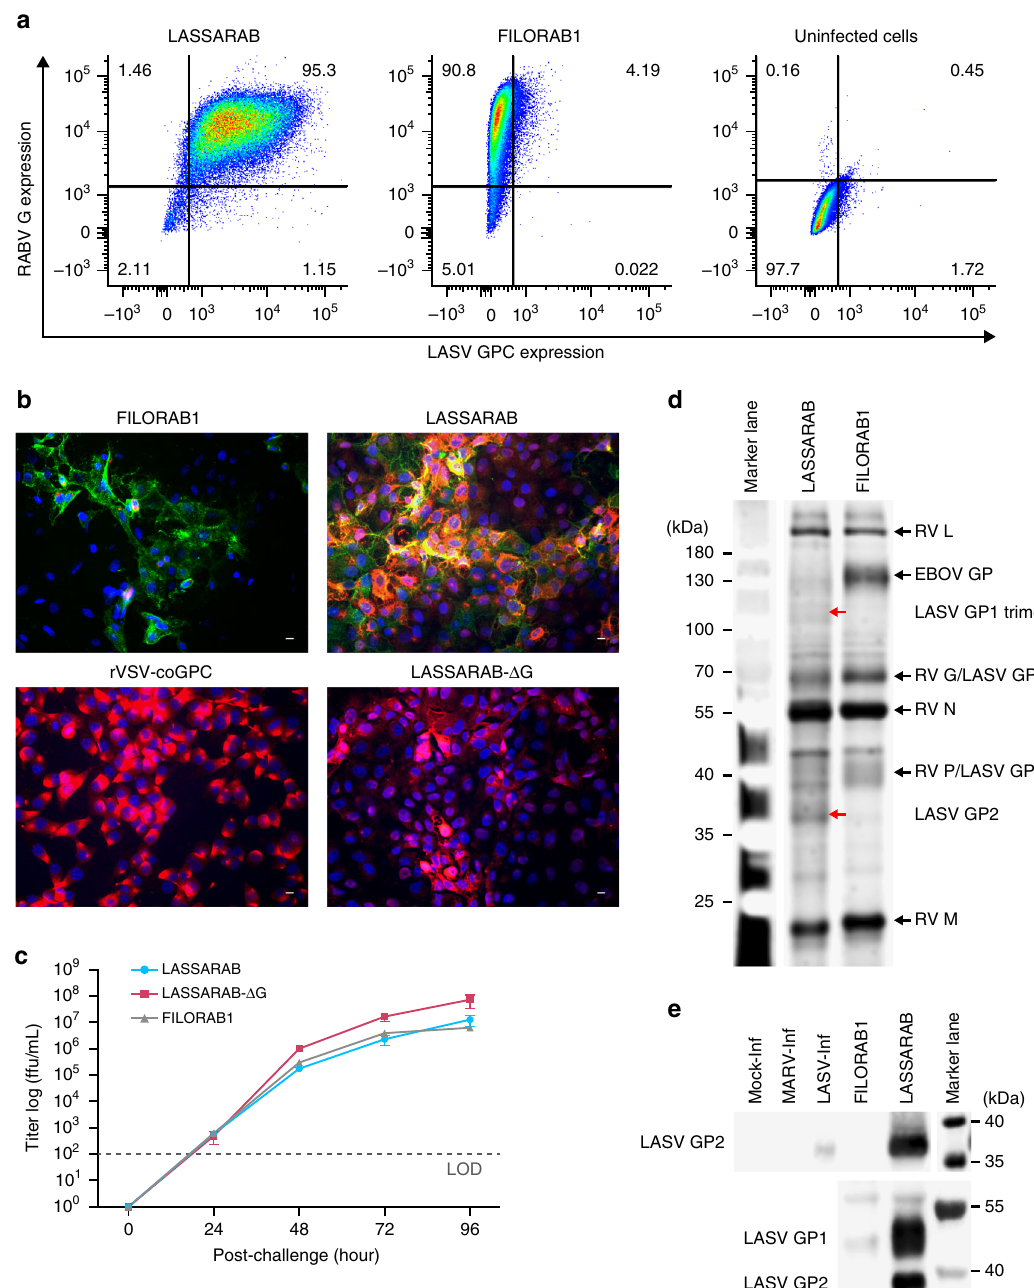
Fig. 2 Evaluation of LASSARAB and LASSARAB- Δ G vectors in cell culture and inactivated virion characterization. a LASSARAB, FILORAB1 and uninfected VERO cells were probed for LASV-GPC and RABV-G expression with 37.7H anti-LASV human mAb and 1C5 anti-RABV G mouse mAb and analyzed by fl ow cytometry 48 h post infection. b VERO cells were infected at a MOI of 0.1 with 4 viruses: FILORAB1, LASSARAB, LASSARAB- Δ G, and rVSV-coGPC. 48 h later (24 h for VSV based vectors) cell surface expression of LASV glycoprotein (GPC), in red, and RABV glycoprotein (G), in green, was probed by a α -LASV GPC rabbit polyclonal and a α -RABV G human 4C12 monoclonal, respectively. In LASSARAB infected cells, yellow is observed as the superimposition of LASV GPC surface expression with RABV G. The bar indicates 12 μ m. c VERO CCL-81 cells were infected with a MOI of 0.01 and